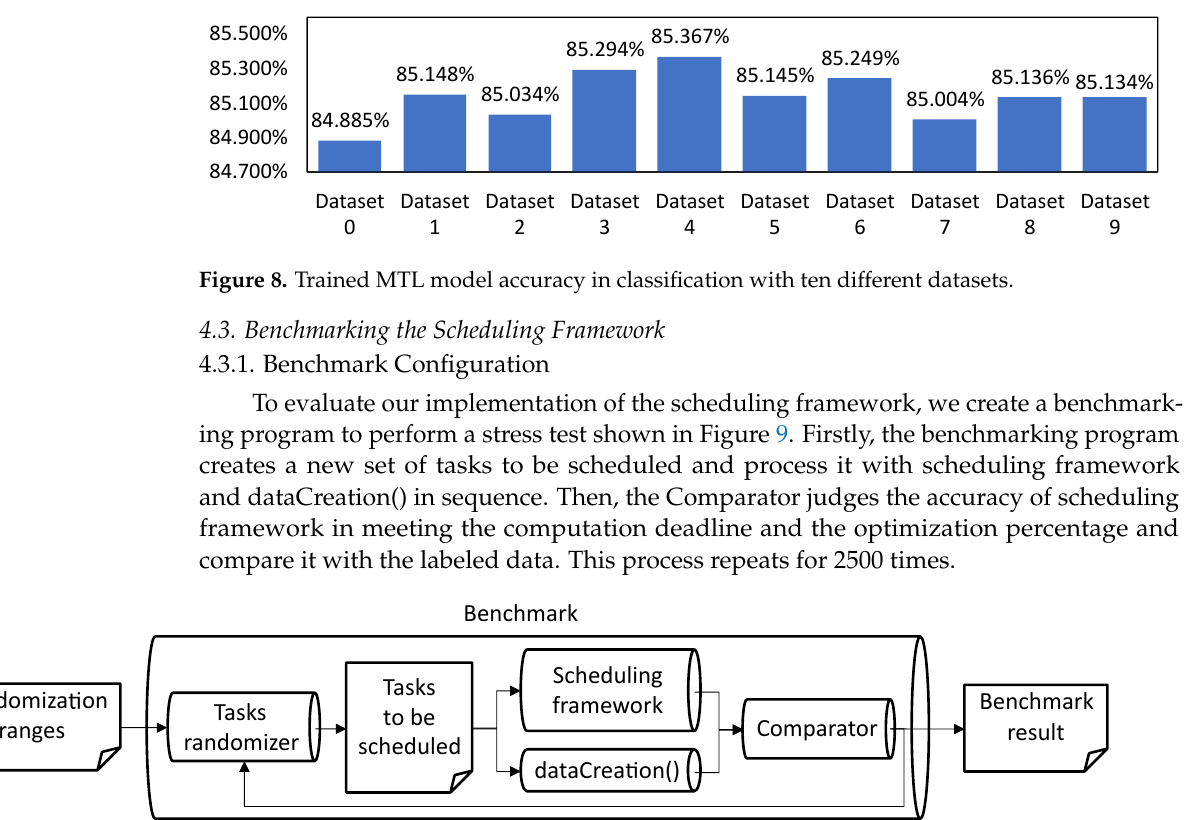
Figure 9. Overview on the benchmarking program we used to test the scheduling